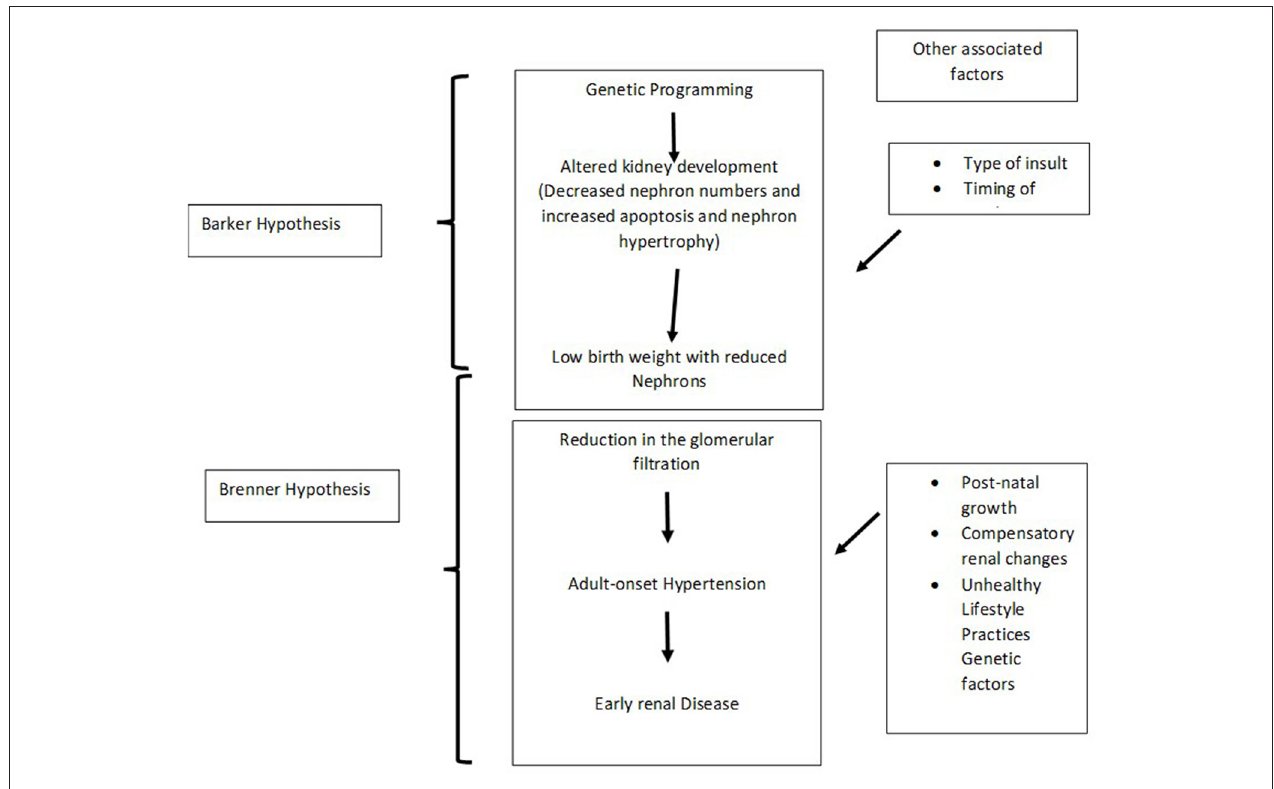
FIGURE 2 | Integration of the Barker and Brenner